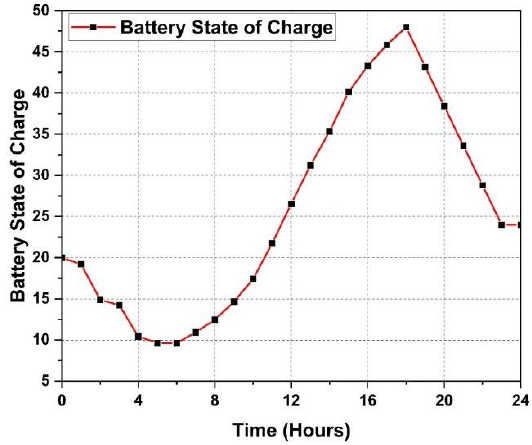
Figure 9. Battery utilization profile (on− grid).